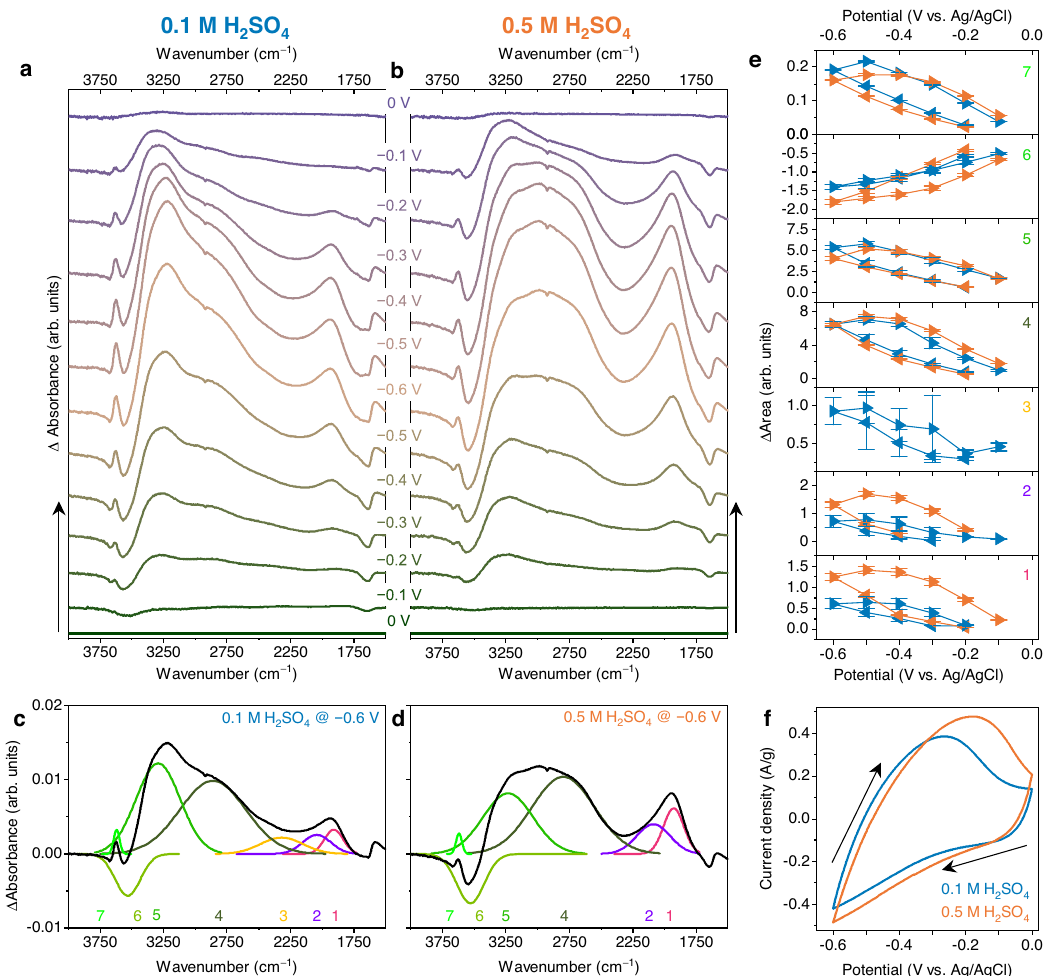
Fig. 2 | Operando electrochemical IR spectroscopy on Ti 3 C 2 T x electrodes. a , b FTIR difference spectra measured during electrochemical cycling in 0.1M H 2 SO 4 ( a ) and 0.5M H 2 SO 4 ( b ). The spectrum recorded at 0V is subtracted from subsequent spectra. Spectra are offset for clarity. c , d Peak fi t of difference spec- trum at − 600mV in 0.1M H 2 SO 4 ( c ) and 0.5M H 2 SO 4 ( d ). The fi t components are